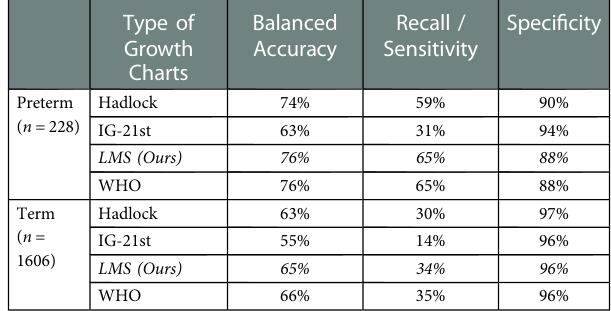
TABLE 4 Result of different fetal growth reference charts in predicting SGA for preterm and term